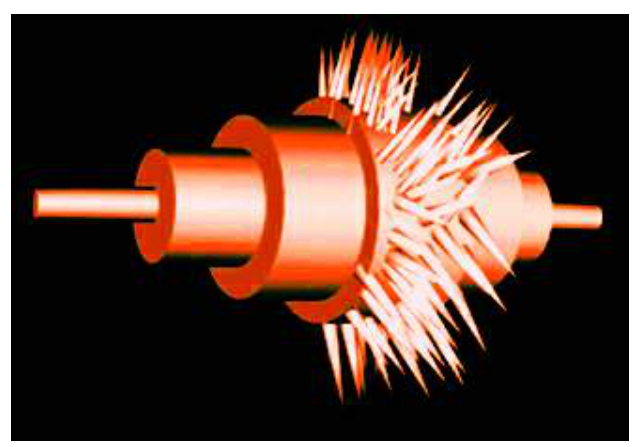
FIGURE 2 . The human character is an extension of the life purpose. A 35- year-old female patient, architect, made this drawing using her favorite computer program. It shows in the center the purpose of life giving energy to the harsh and effective physical character through the spiritual and mental